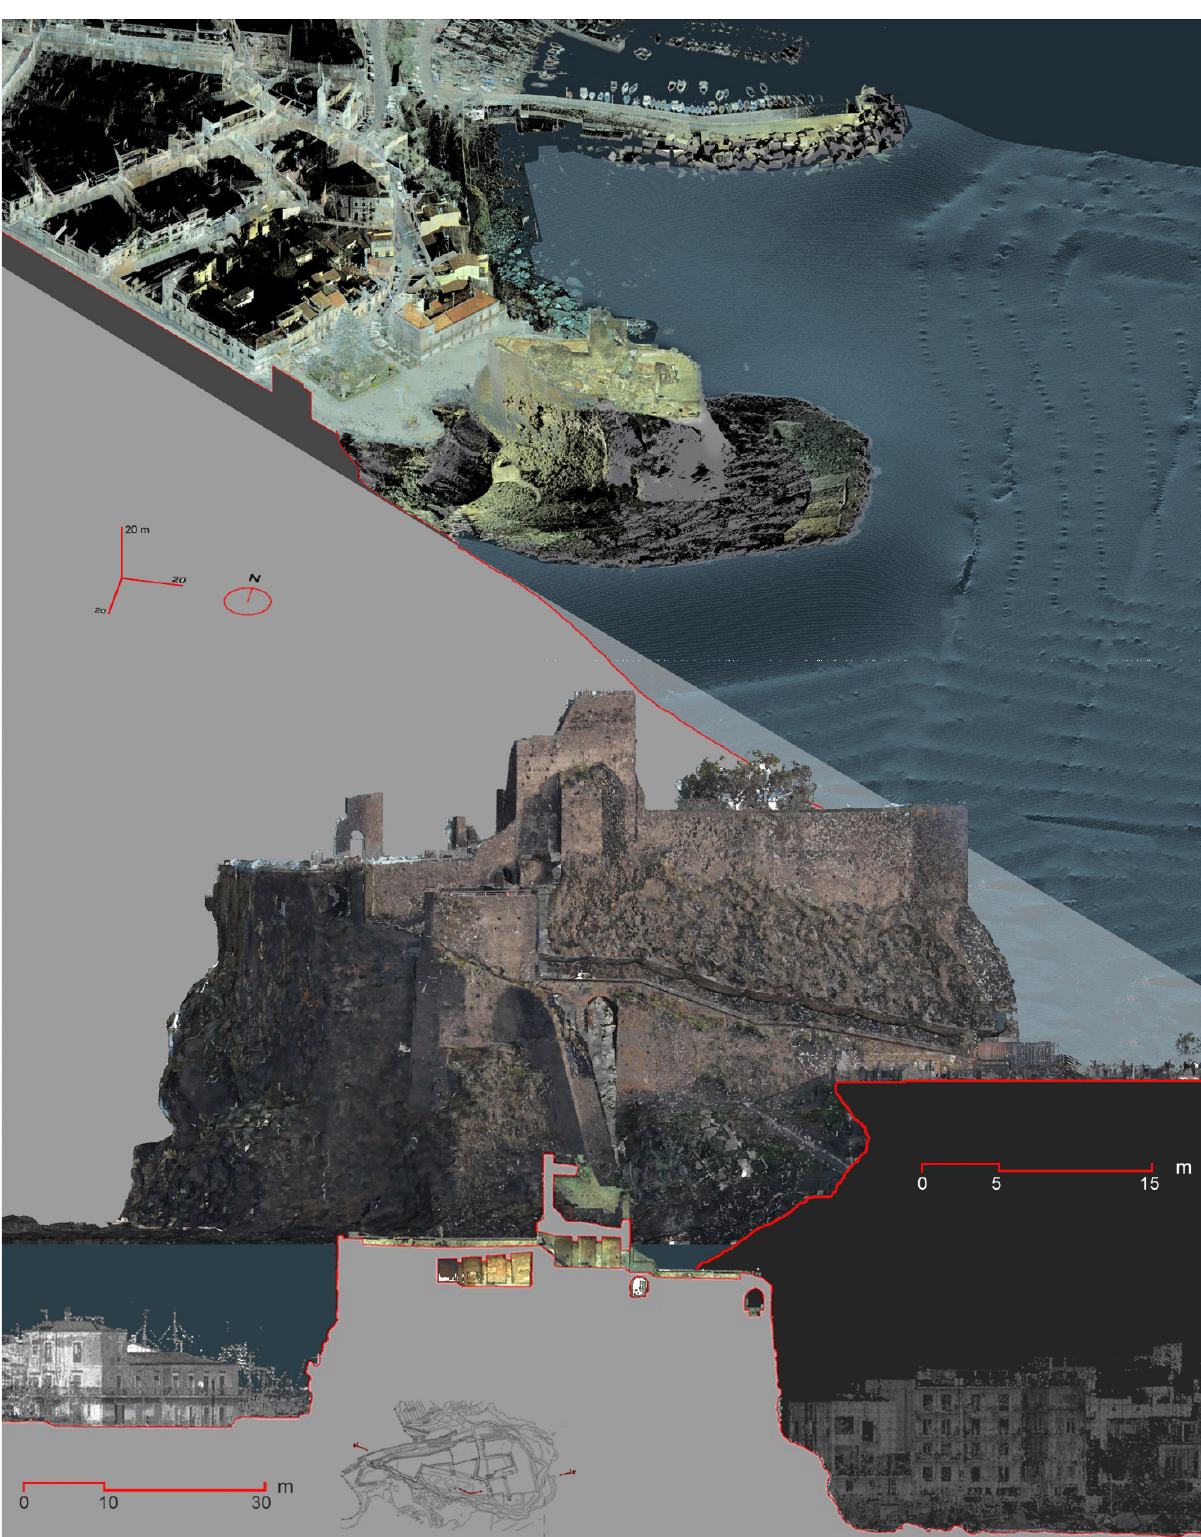
Figure 4: Multi-scale views of the 3D model of Aci Castello, to analyse the logic of any reciprocal spatial-morphological relationship between the natural site, urban settlement and historical